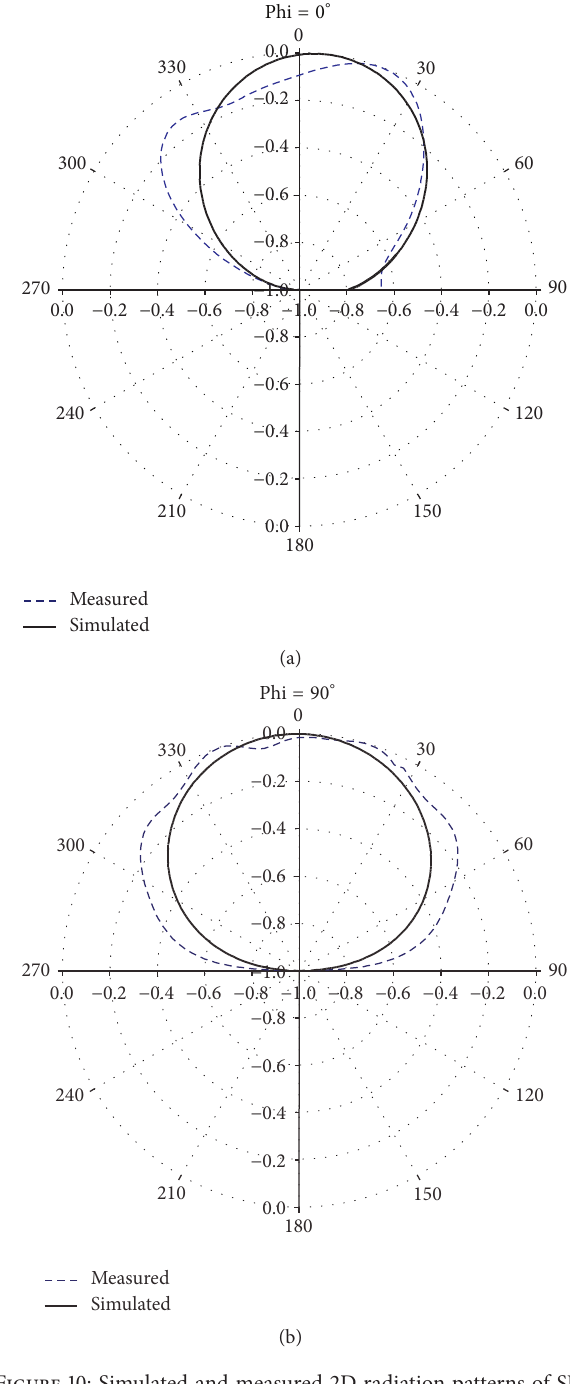
Figure 10: Simulated and measured 2D radiation patterns of SRR based PIFA for 6 GHz at (a) 𝜙 = 0 ∘ and (b) 𝜙 = 90 ∘ . of 6, 10, and 15 GHz, the peak gains were 3.4 dBi, 4.9 dBi, and 5.85 dBi,